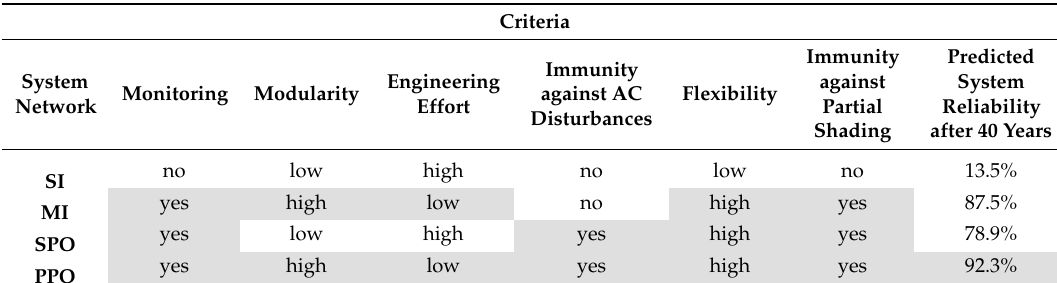
Table 1. The qualitative and quantitative analysis of possible BIPV electrical installation architectures. The grey boxes indicate the preferred